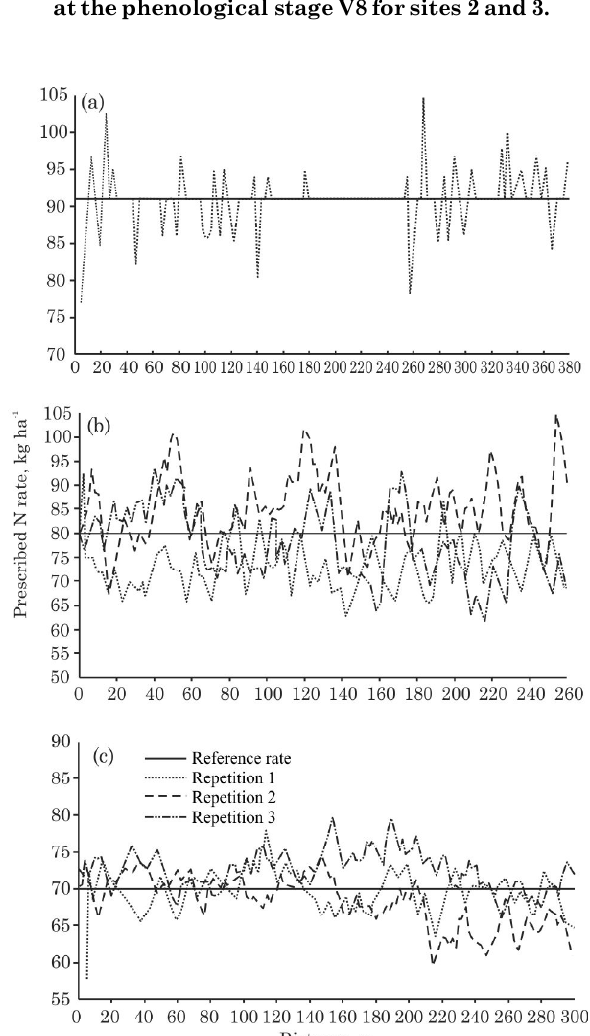
Figure 2. Nitrogen fertilization rate estimated by the optical sensor following the corn vegetation index at the phenological stage V8 for sites 2 and